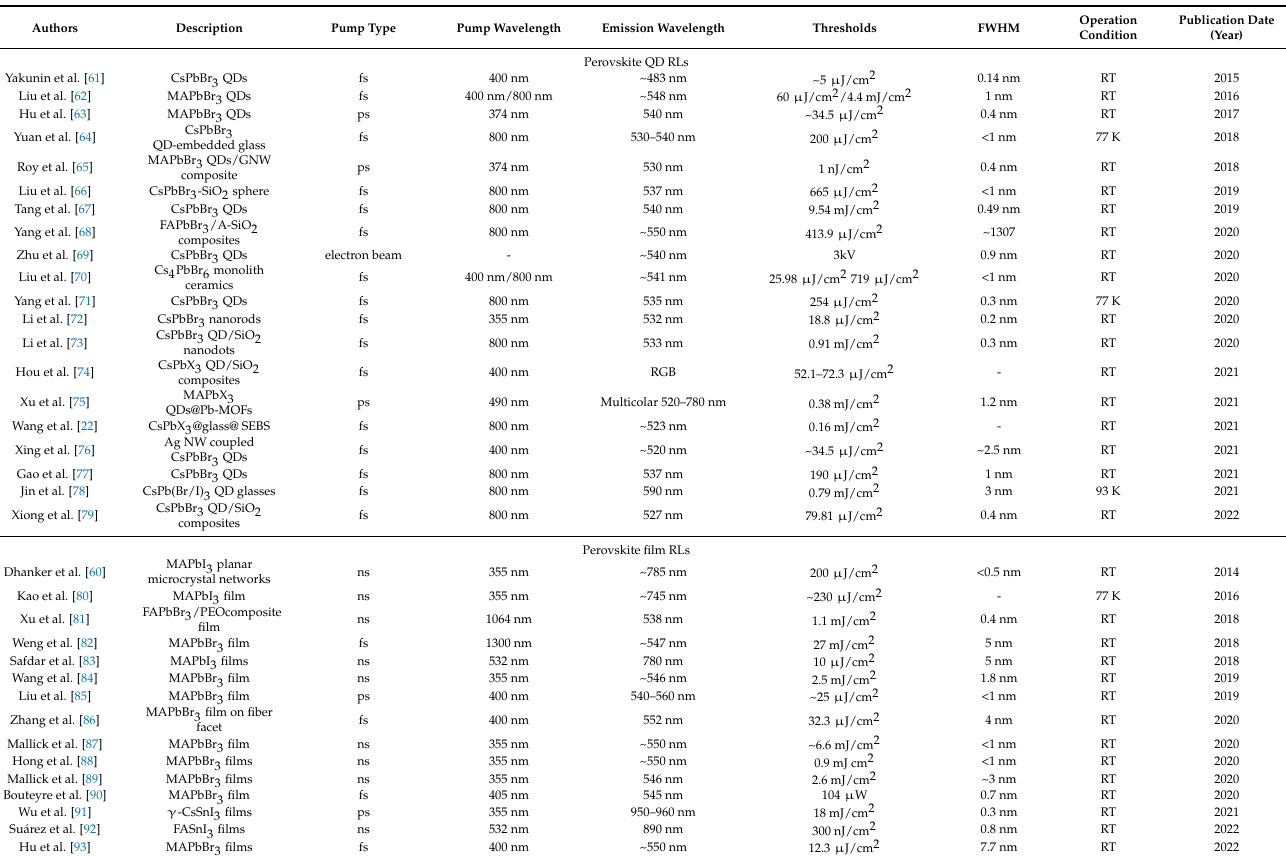
Table 1. Selected representative results of RLs from halide perovskite gain